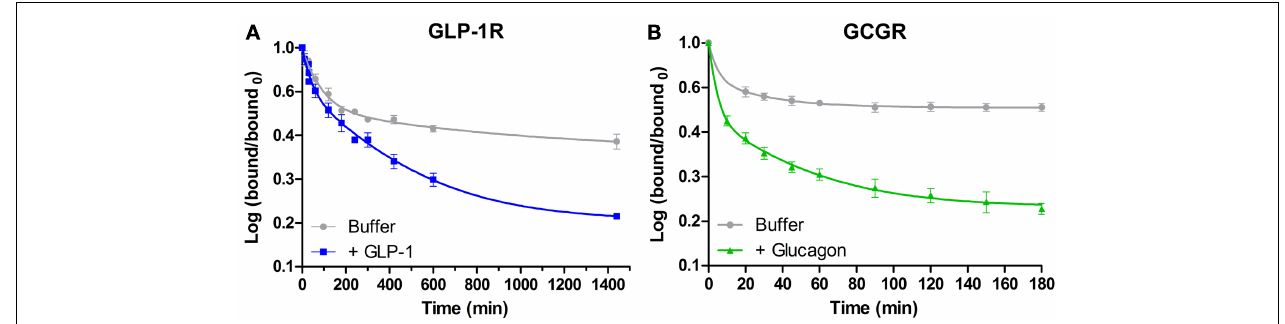
FIGURE 3 | Dissociation experiment investigating negative cooperativity in the binding of GLP-1 and glucagon to the GLP-1R and the GCGR, respectively. These dissociation assays were carried out as described by De Meyts et al. (1973) for the insulin receptor. In this procedure, a small fraction of the surface expressed receptors are pre-occupied by 125 I-labeled ligand in an initial association step followed by dissociation in an “infinite dilution” of either buffer of buffer containing an excess of unlabeled ligand. Accelerated dissociation of 125 I-labeled ligand in the presence of unlabeled ligand indicates the presence of negative binding cooperativity.The data are plotted as the logarithm of bound/bound 0 as a function of time in minutes and fitted to a two-site exponential decay model in GraphPad Prism. All data represent mean ± SD of three independent experiments carried out in duplicates.